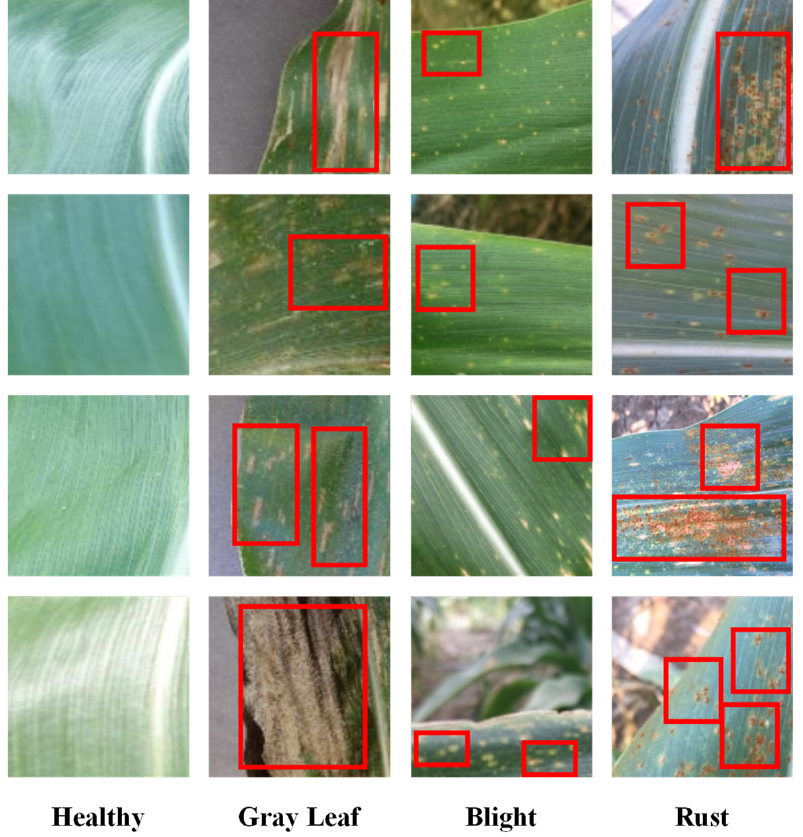
Figure 1. Depiction of diseased and healthy maize leaves from the Plant Village dataset. Note that the red rectangles correspond to maize disease the red rectangles correspond to maize disease characteristics.